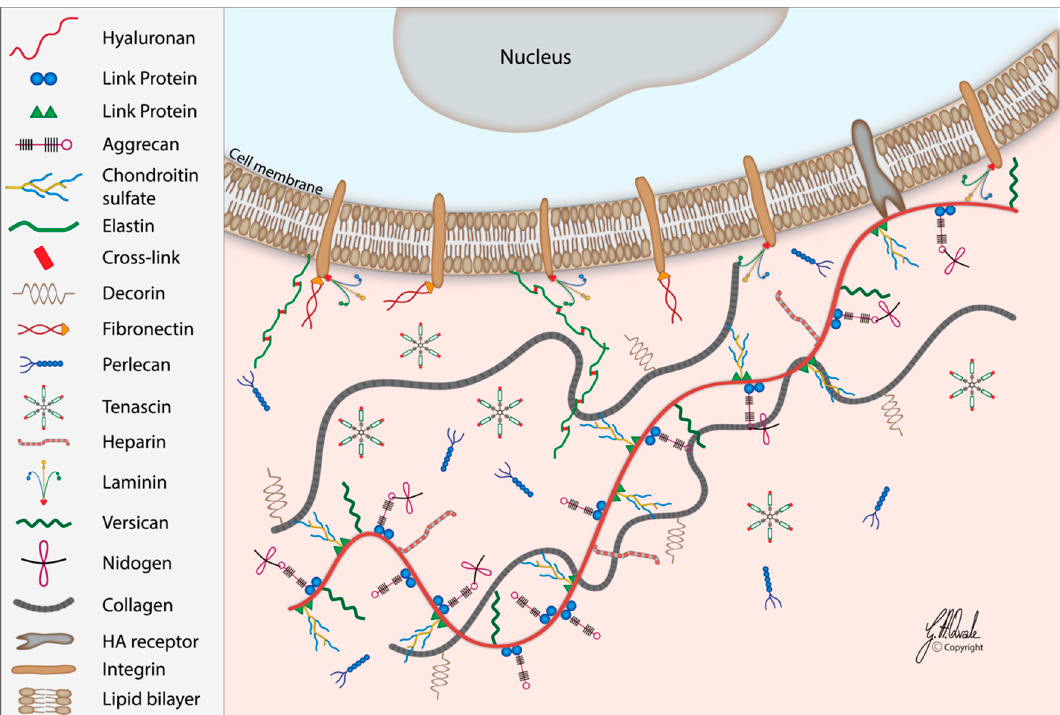
Figure 2. Schematic structure and interactions between some components of the extracellular matrix. Proteoglycans (e.g., versican, aggrecan, and decorin) and glycosylated proteins form strong covalent bonds between anionic amino acids and glycosaminoglycans (GAGs) (e.g., hyaluronan, chondroitin sulfate, and heparin) through link proteins. Glycoproteins (e.g., elastin, laminins, fibronectins, and tenascins) link structural molecules between each other as well as structural molecules and cells. Collagens, major insoluble fibrous proteins in the extracellular matrix (ECM), associate with other molecules, especially elastin.